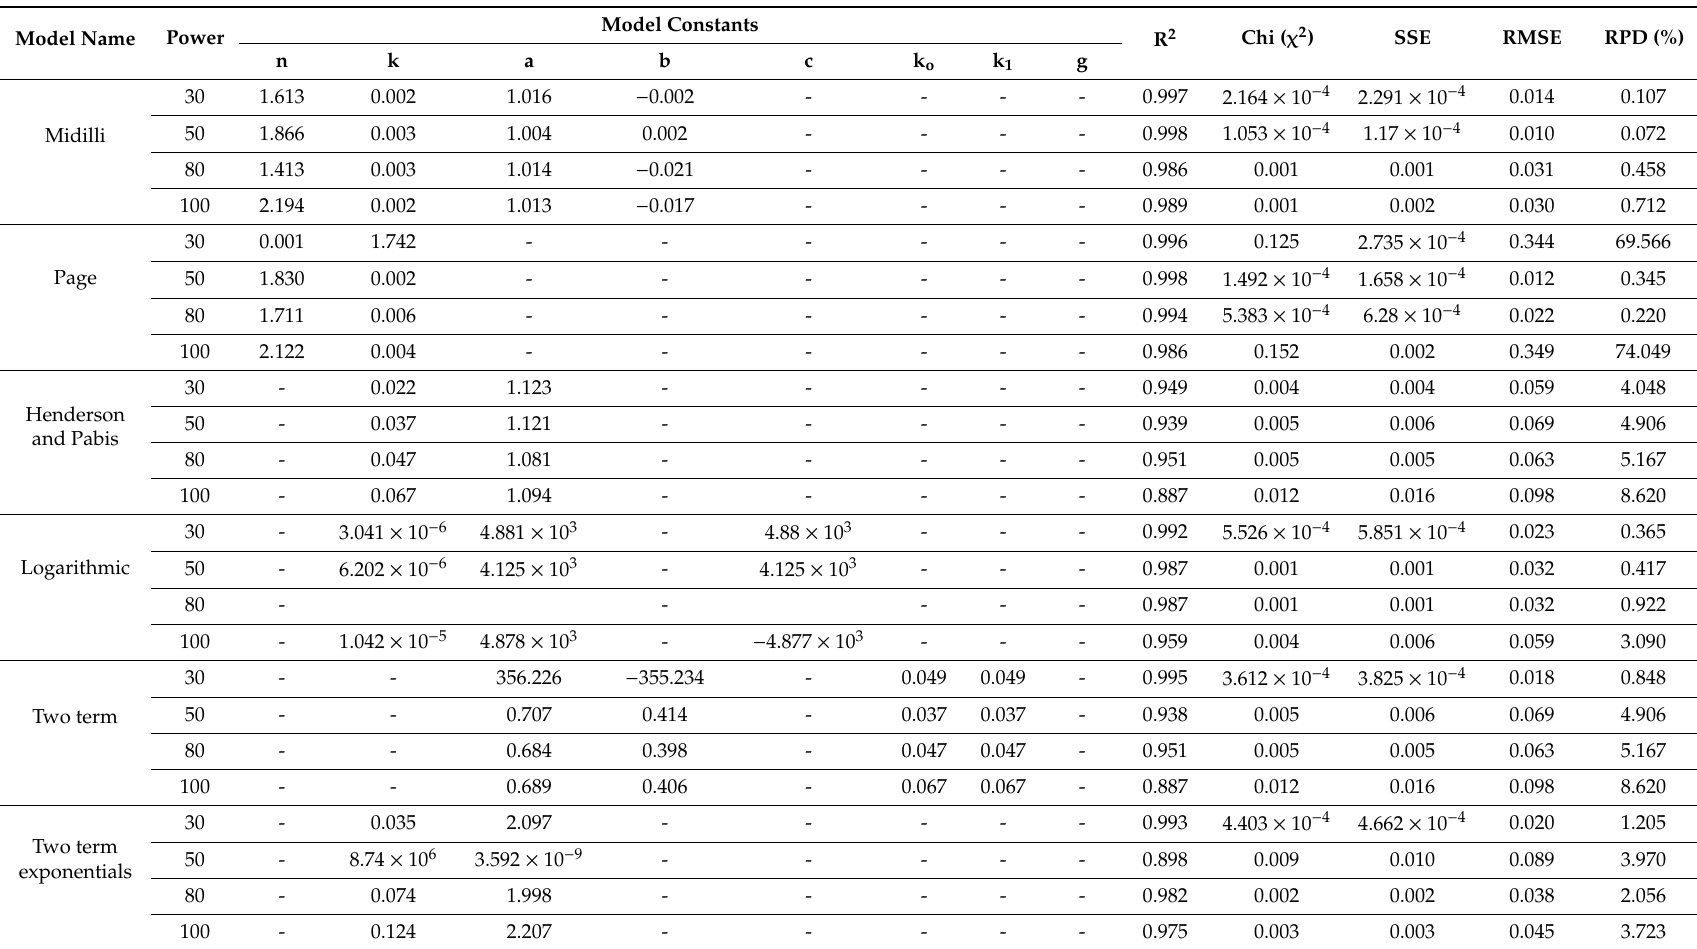
Table 1. A statistical evaluation of various kinetic models for microwave assisted evaporation at di ff erent